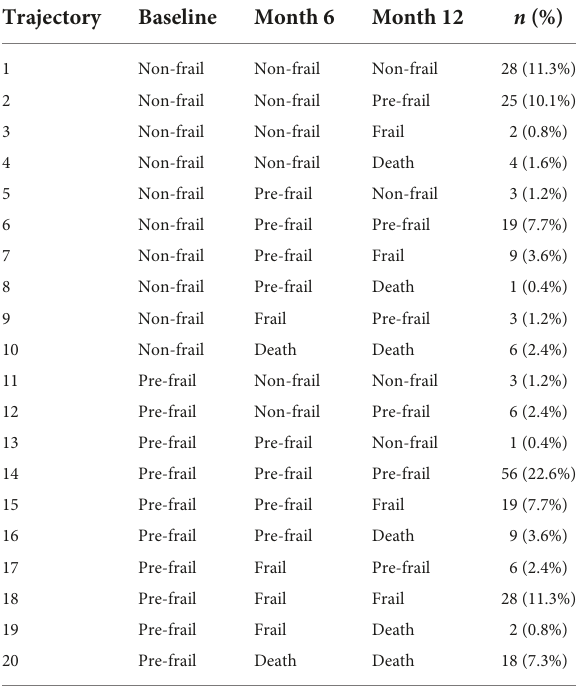
TABLE 2 Frailty transitions identified over 12